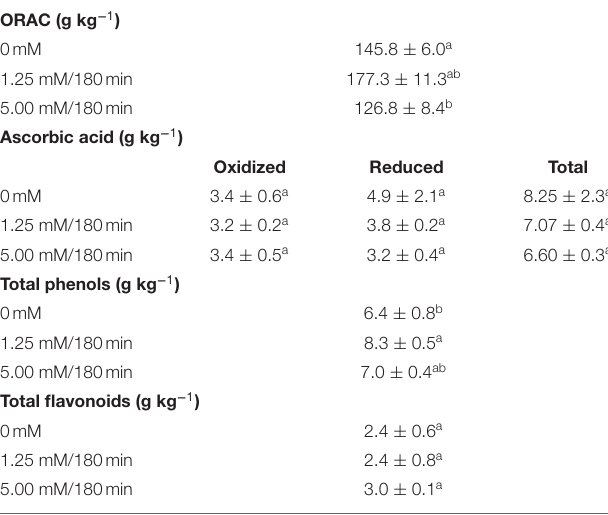
TABLE 1 | Oxygen radical absorbance capacity (ORAC, Trolox equivalents), ascorbic acid (oxidized, reduced, total), total phenols (gallic acid equivalents), and total flavonoids (quercetin equivalents), contents in broccoli florets exposed to